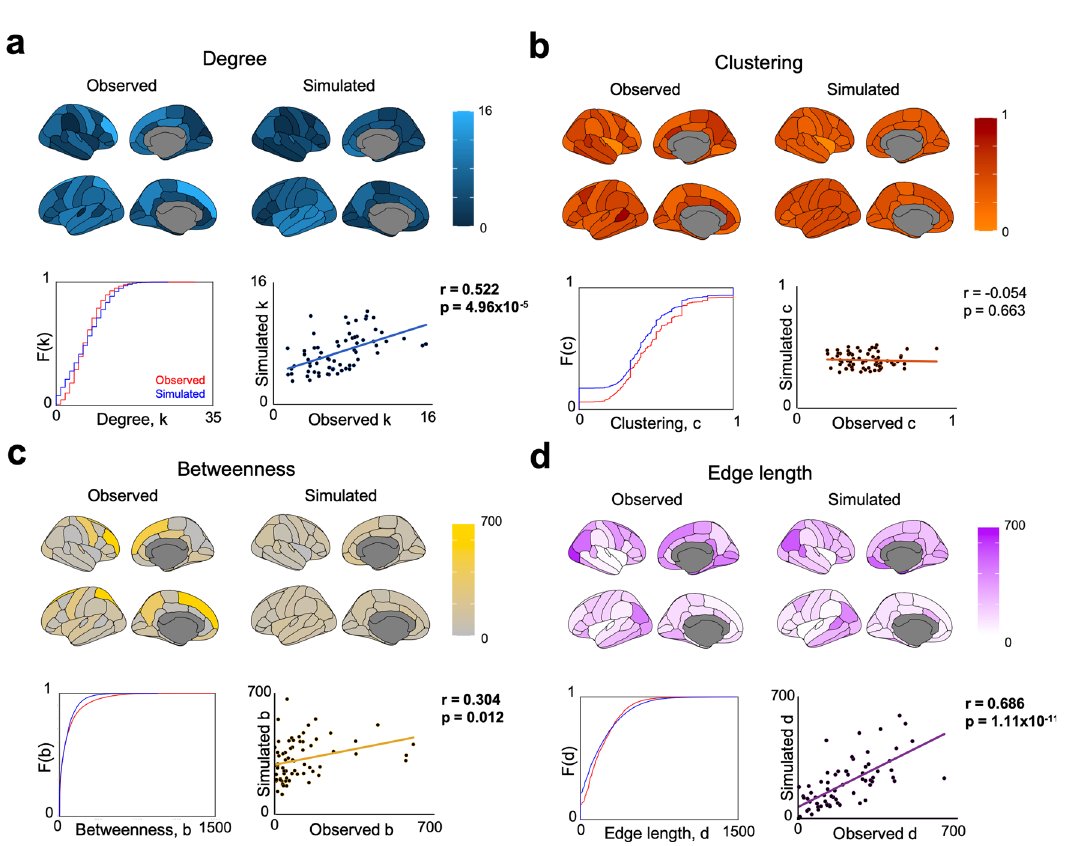
Fig. 3 Spatial embedding of simulated networks grown via optimized homophily generative mechanisms. For each network measure, we present the cumulative density functions across all observed versus simulated nodes within each network. Each point in the scatter plot shows one of the 68 across- subject average nodal measures from the observed and optimally simulated networks. We also show a visualization of these measures. All statistics were computed via two-tailed linear correlations, quoting the Pearson ’ s correlation coef fi cient. a Degree between observed and simulations are signi fi cantly positively correlated ( r = 0.522, p = 4.96 × 10 − 5 ). b Clustering between observed and simulations at not correlated ( r = − 0.054, p = 0.663). c Betweenness centrality between observed and simulations are signi fi cantly positively correlated ( r = 0.304, p = 0.012). d Edge length (as a summation of all edges from each node) between observed and simulations are signi fi cantly positively correlated ( r = 0.686, p = 1.11 × 10 − 11 ). Boldened values are signi fi cant correlations at p < 0.05. In Supplementary Fig. 4, we present a parallel analysis including local and global measures not included in the energy equation. In Supplementary Fig. 5, we demarcate for each measure the generative error in spatial embedding, and show the ranked performance for each it allows us to probe the underlying mechanisms occurring over the development of the network 38 . As one explicitly speci fi es the generative mechanisms involved, the statistical properties which “ fall out ” of the network can be considered as spandrels 39 ; epi- phenomena of the network ’ s development according to the much simpler economical trade-off (in this case, according to the homophily principle). If the generative model is indeed capturing biologically relevant processes, one would expect the wiring equation — at a minimum — to reduce the network ’ s dimension- ality simply into the two wiring parameters used to construct it.